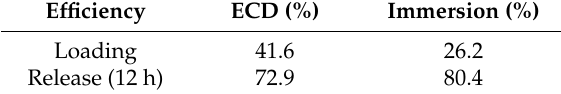
Figure 5. Viabilities of MG-63 cells cultured on treated Ti samples. The cell proliferation rate increased significantly with Ti-0.8 V, Ti-1.2 V, and Ti-1.6 V. Table 1. Drug loading and release rates of BMP-2 from ECD and immersion